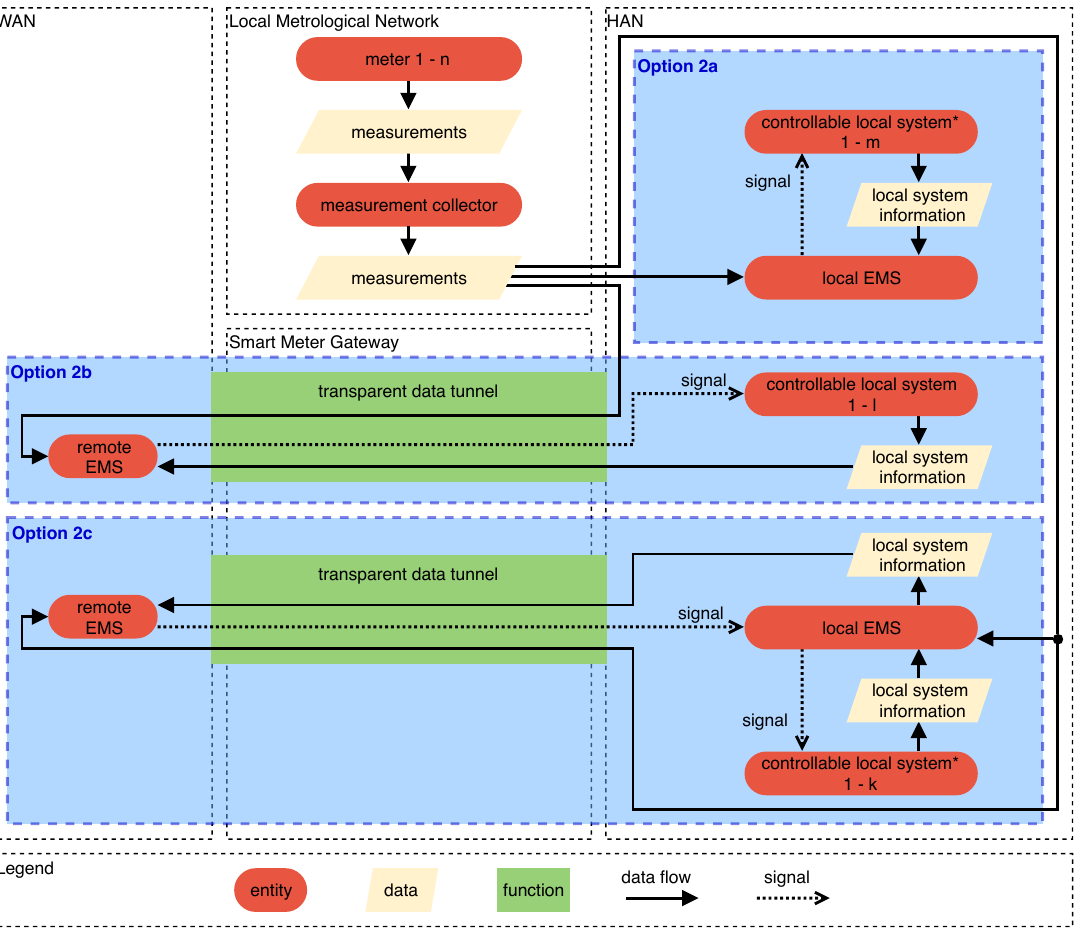
Figure 3. Integration options for Energy Management Systems (EMSs) using the Smart Meter Gateway only for providing a transparent data tunnel, but not for the collection of meter measurements. Controllable Local Systems that are only monitored and controlled from inside the Home Area Network (HAN) are marked with an